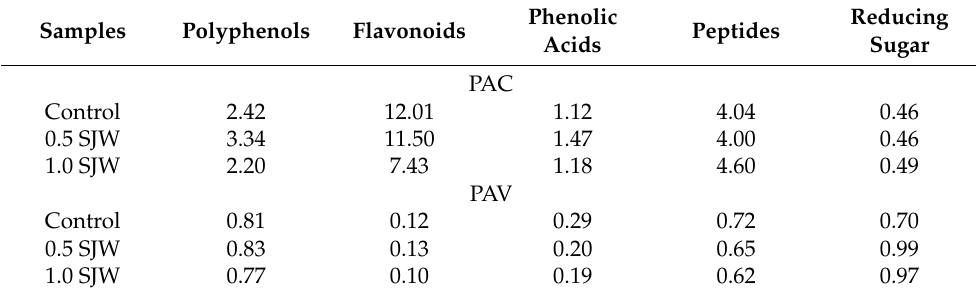
Table 3. PAC and PAV indexes of the bioactive compounds from cookies. Samples